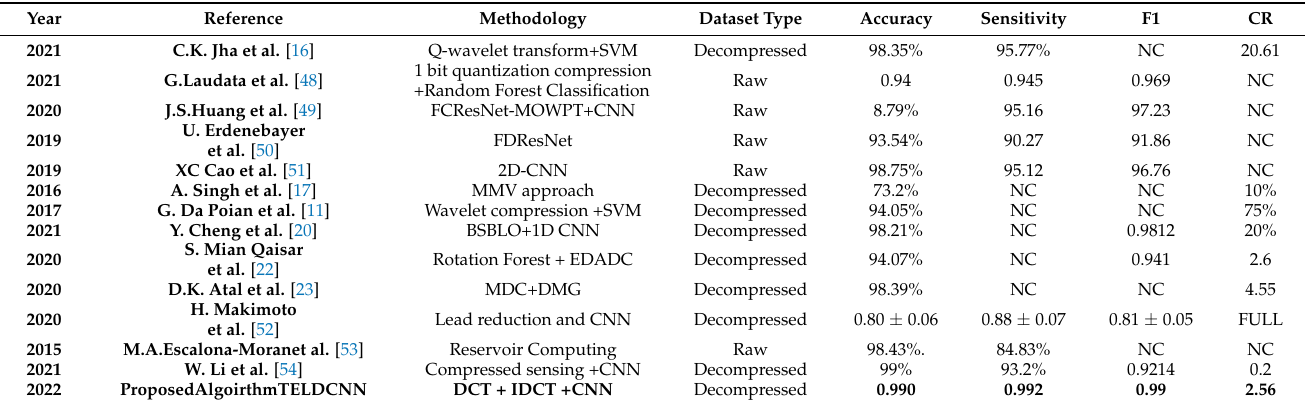
Table 5. Comparison of TELDCNN with other state-of-the-art algorithms.